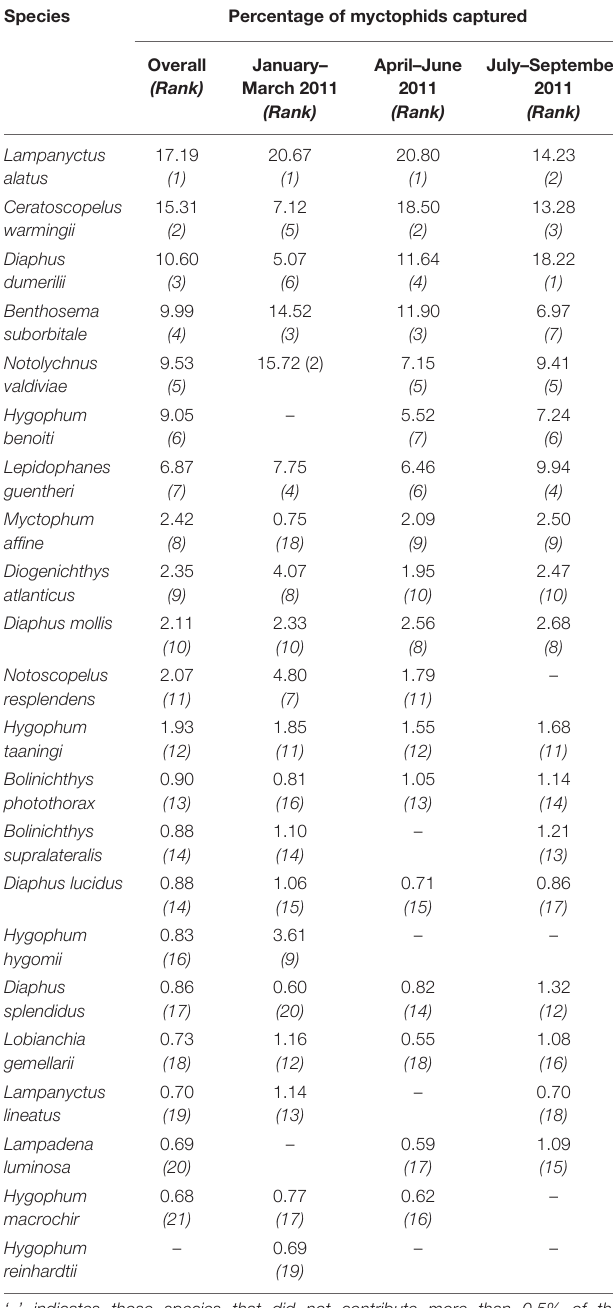
TABLE 2 | Percentage contribution to the total myctophid assemblage captured during 2011 from each cruise series.